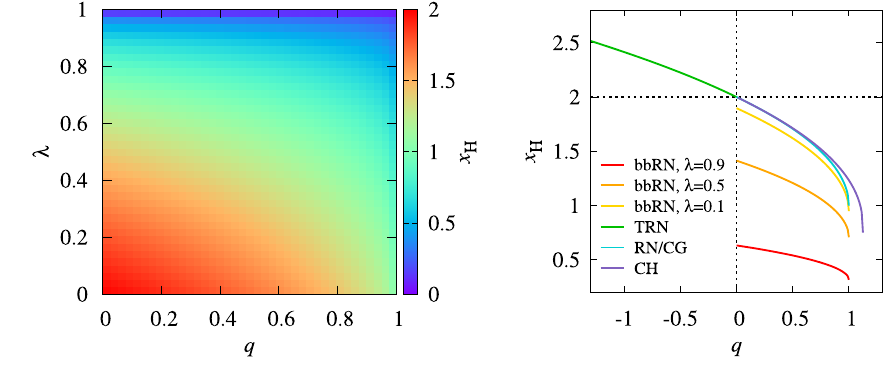
Fig. 1 Left panel: The dimensionless radius x H of the outer event horizon for the black-bounce-Reissner– Nordström spacetime with respect to q and λ . Right panel: A comparison of x H among the black-bounce-Reissner– Nordström spacetime (bbRN), the Reissner–Nordström black hole (RN), the tidal Reissner–Nordström black hole (TRN), the charged Horndeski black hole (CH) and the charged Galileon black hole